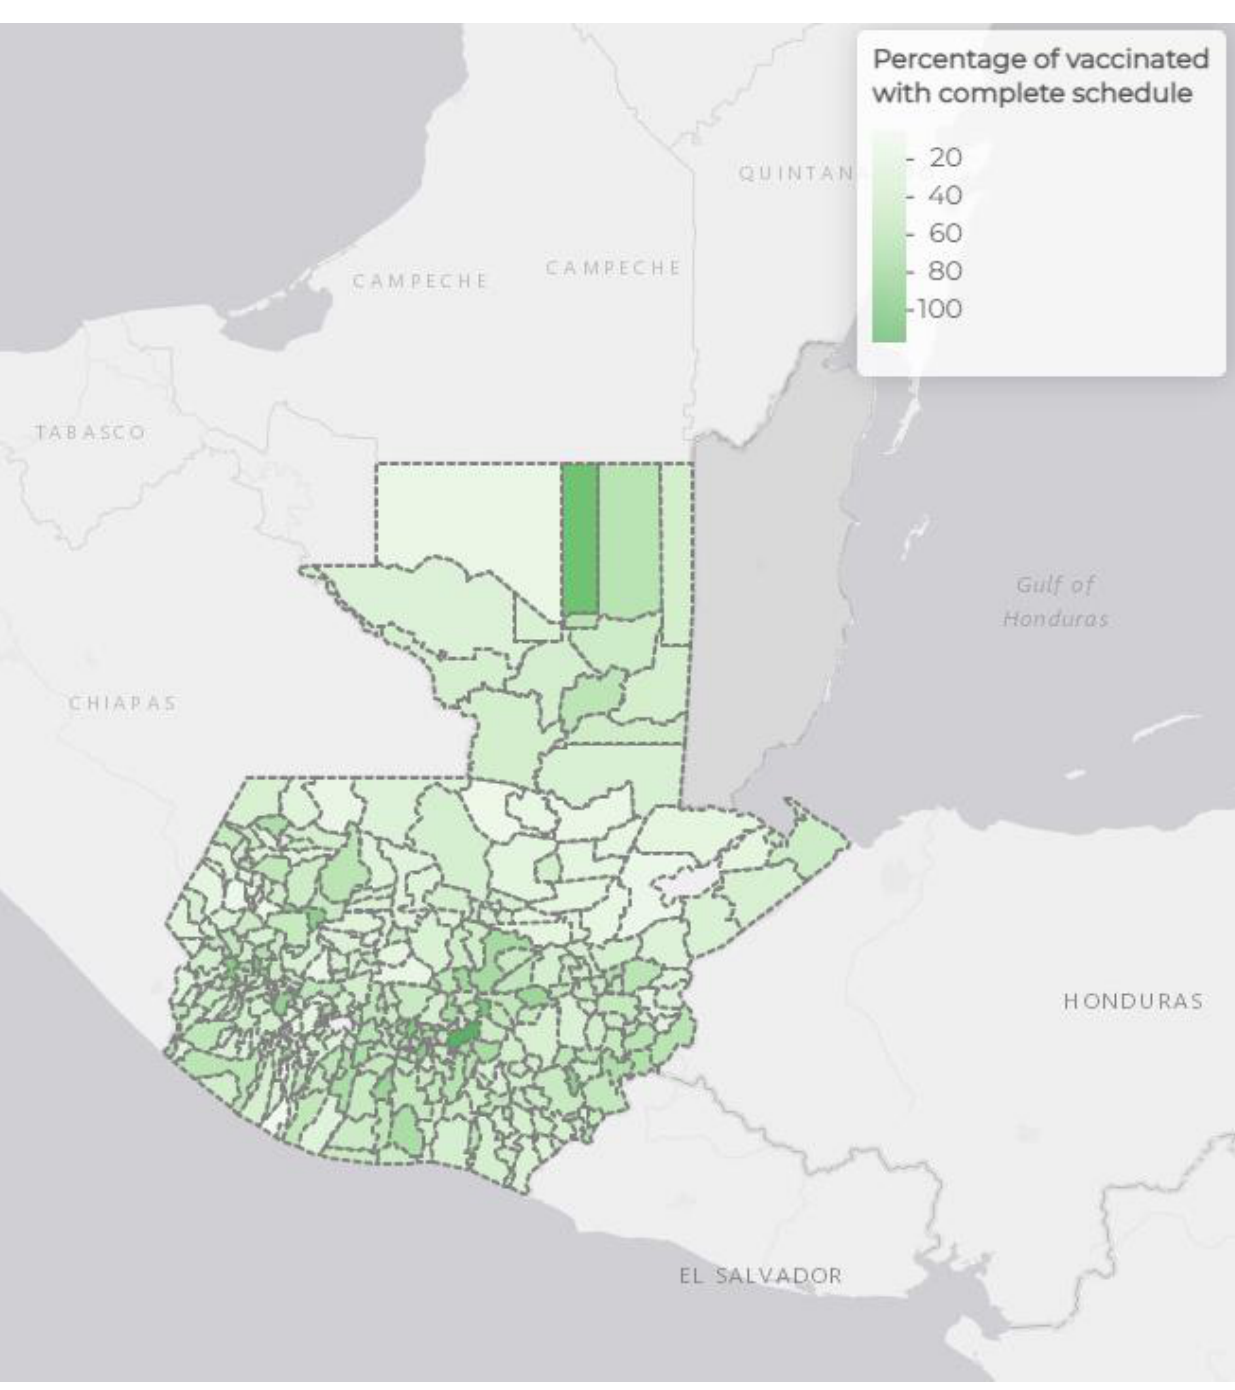
Table 2. Demographic characteristics among the 340 municipalities and 22 departments in Guate- mala. Data source: Guatemala Population and Housing Census 2018, 2014–2015 Demographic and